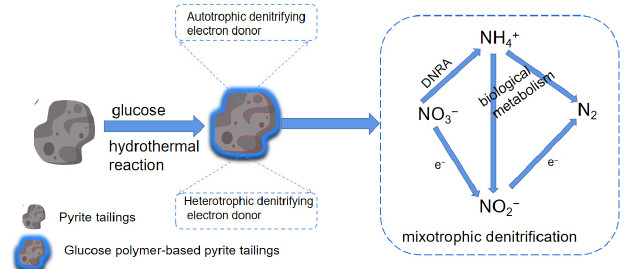
Figure 1. Heterotrophic-sulfur autotrophic mixed denitrification system.